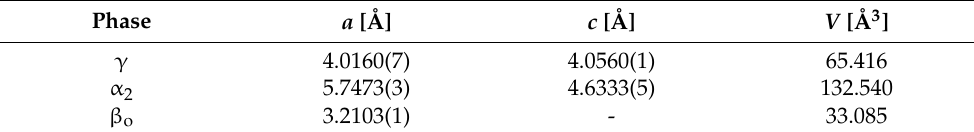
Table 1. Lattice parameters and unit cell volumes at RT for the three occurring phases as calculated with Maud. The numbers in brackets give the error in the last digit.